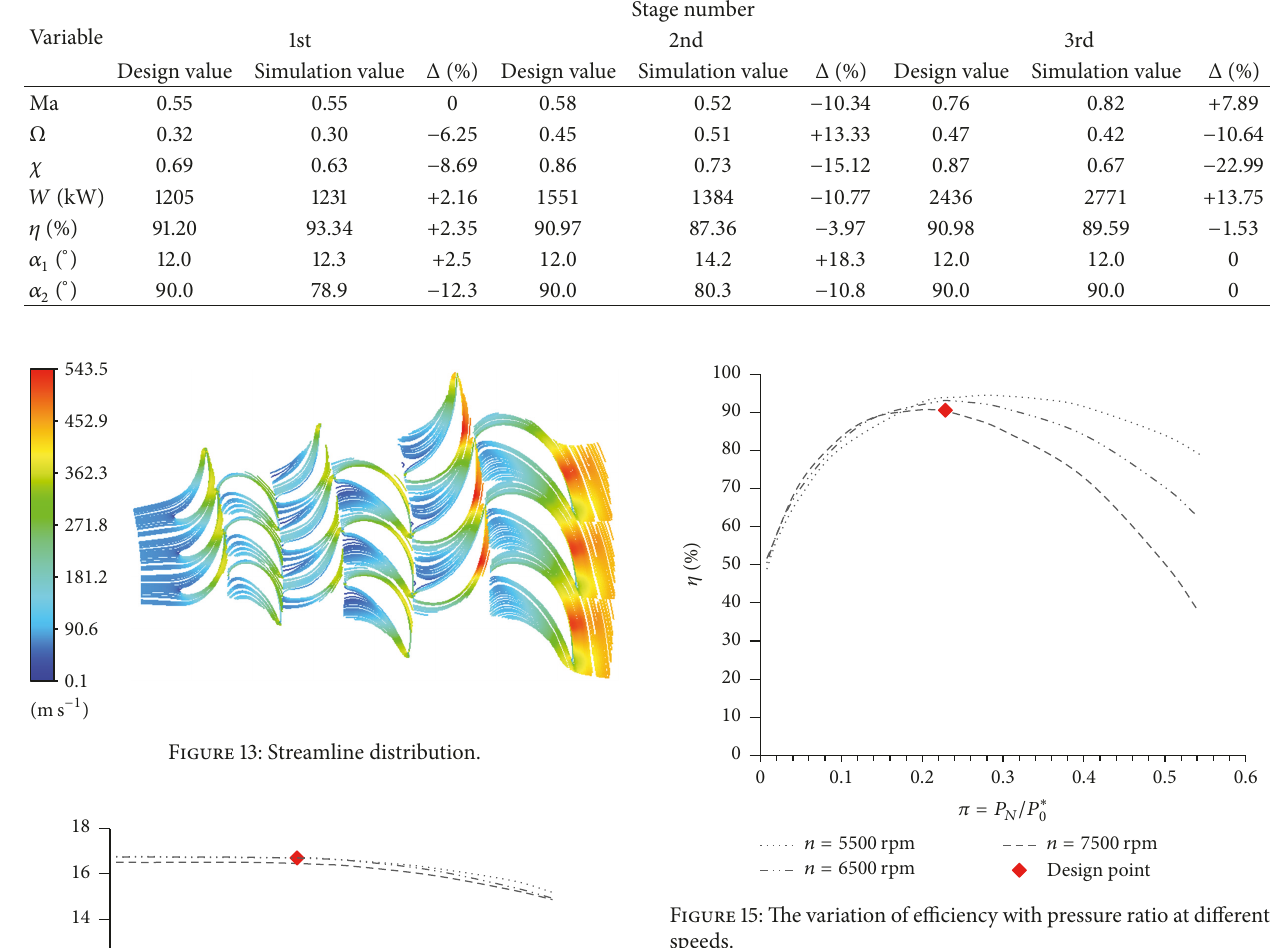
numerical simulation results of the three-stage centrifugal turbine and the analysis of the off-design